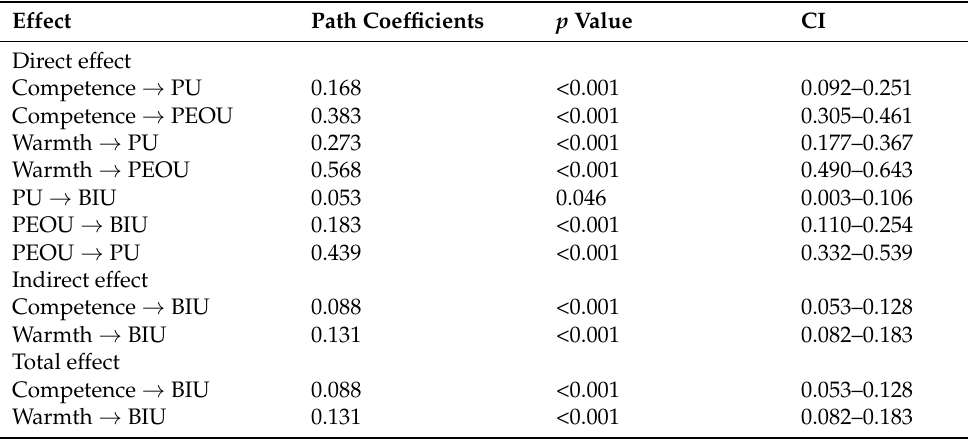
Table 6. Path coefficients by